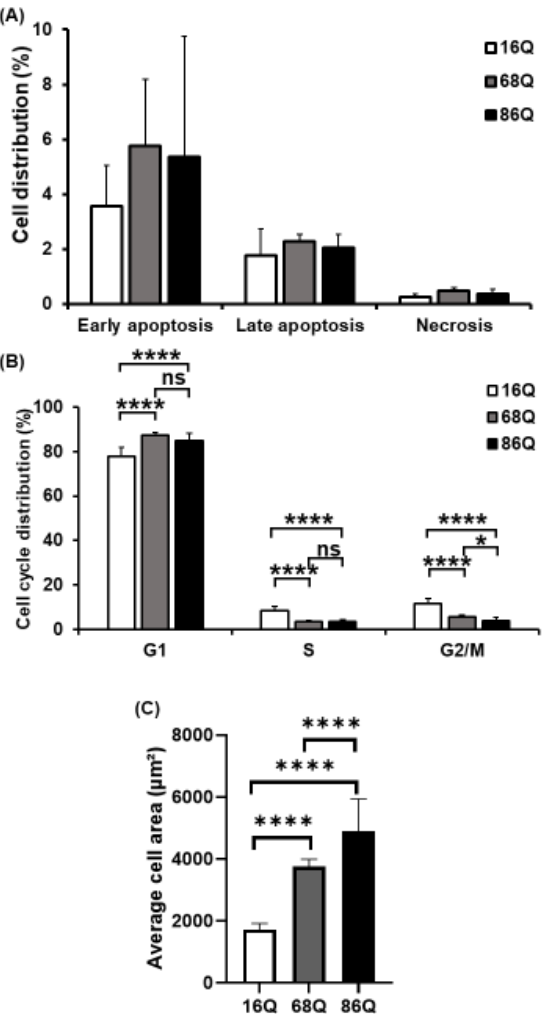
Figure 3. Decreased mitotic rate and increased cell size of juvenile HD fibroblasts. ( A ) Assessment of cell viability by flow cytometry using Annexin-V-FITC and PI. The results are presented as the mean ± SD of three independent experiments. Cell lines were compared using ANOVA test by GraphPad Prism 8.2.1 (* indicates p < 0.05, ** indicates p < 0.01, *** indicates p < 0.001 as compared to control). ( B ) Cell cycle distributions were measured by flow cytometry 24 h after synchronized cell seeding and staining cells with 10 µg/mL propidium-iodide (PI). Results are displayed as mean ± SD of four independent experiments. Statistically significant differences were calculated using ANOVA test by GraphPad Prism 8.2.1 (* indicates p < 0.05, ** indicates p < 0.01, *** indicates p < 0.001). ( C ) Cell area in µm 2 was determined by staining HD (68Q and 86Q) and healthy (16Q) fibroblasts with Texas-Red Phalloidin for cytoskeletal F-actin, and DAPI for cell nuclei. High content screening (HCS) measurement and quantification were performed by using the Opera Phenix high content screening system. Statistically significant differences were calculated using ANOVA test by GraphPad Prism 8.2.1. Data represent the mean ± SD, n = 5 (* p < 0.05; ** p < 0.01, *** p < 0.001 **** p < 0.0001).